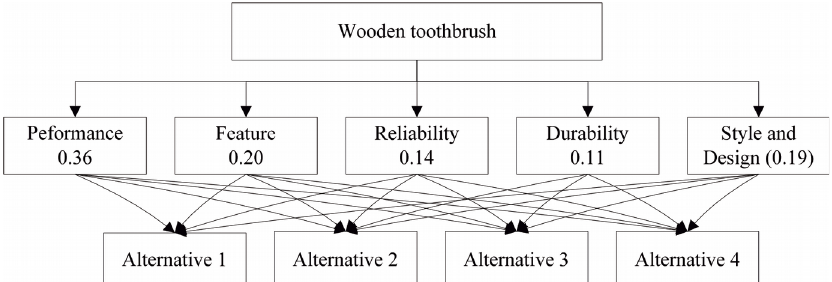
Figure 3. The decision-making hierarchy of wooden toothbrushes